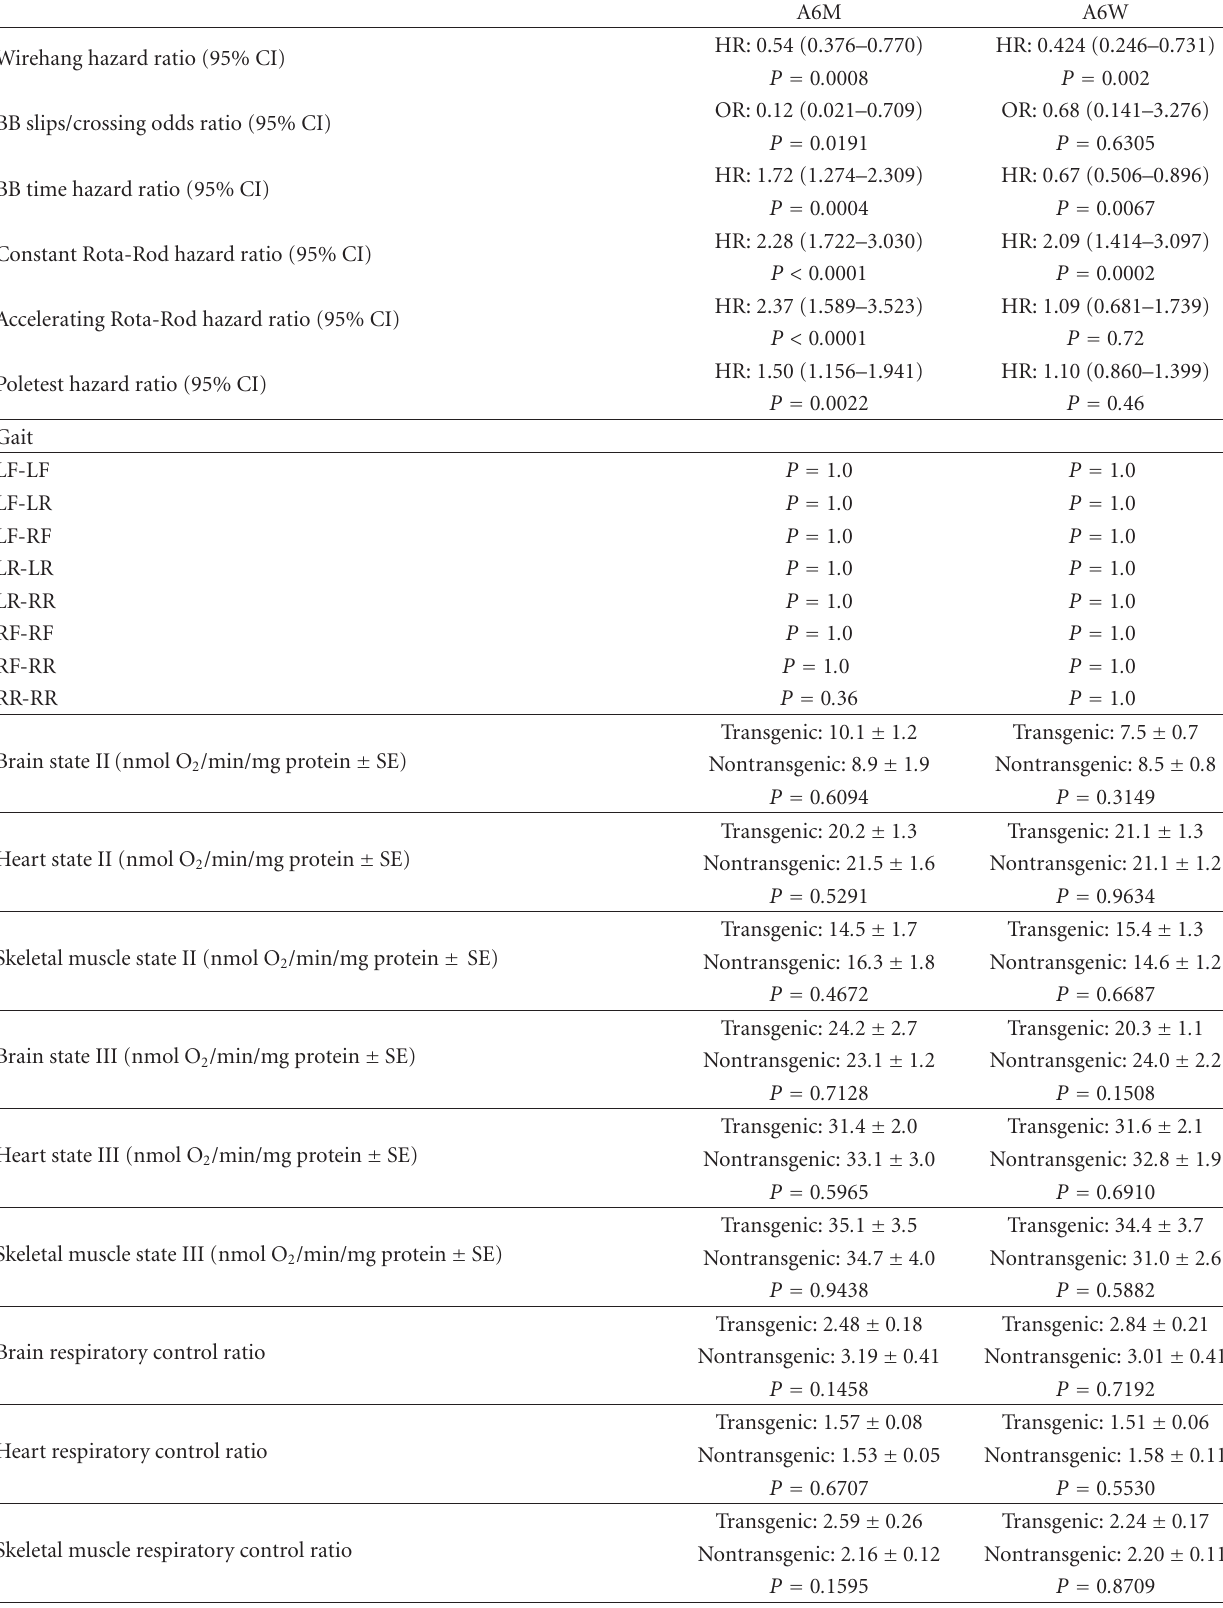
Table 1: Motor and biochemical analyses of A6M and A6W transgenic mice. Hazard and odds ratios are expressed with 95% confidence intervals (95% CI) and P values. Biochemical data are expressed as mean ± standard error of the mean